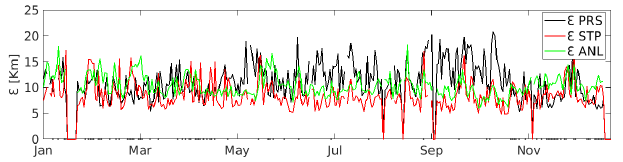
Figure 6. The x axis shows the ε ANL , ordered from minimum to maximum, for the best analog for the test year 2015 for the BoB HFR. The left y axis indicates ε STP (red) and ε PRS (blue) for the corresponding ε ANL . The right y axis indicates the percent of cu- mulative comparison times, as shown by the gray solid line. The dashed vertical line indicates the crossing point between ε STP and ε PRS (ε ANL ∗ = 13 .